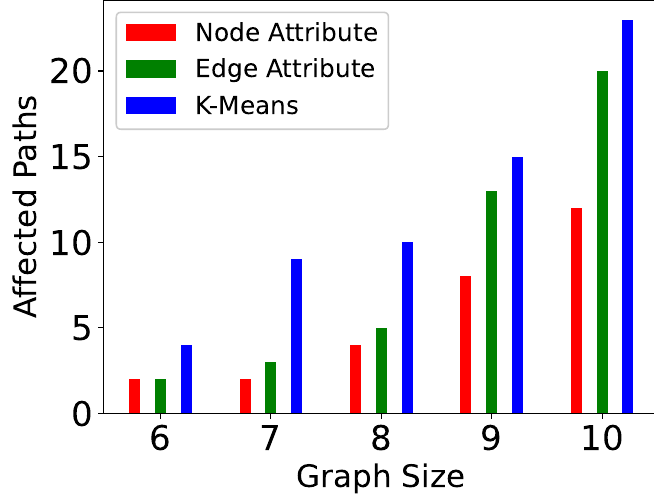
Figure 10. Paths computed in